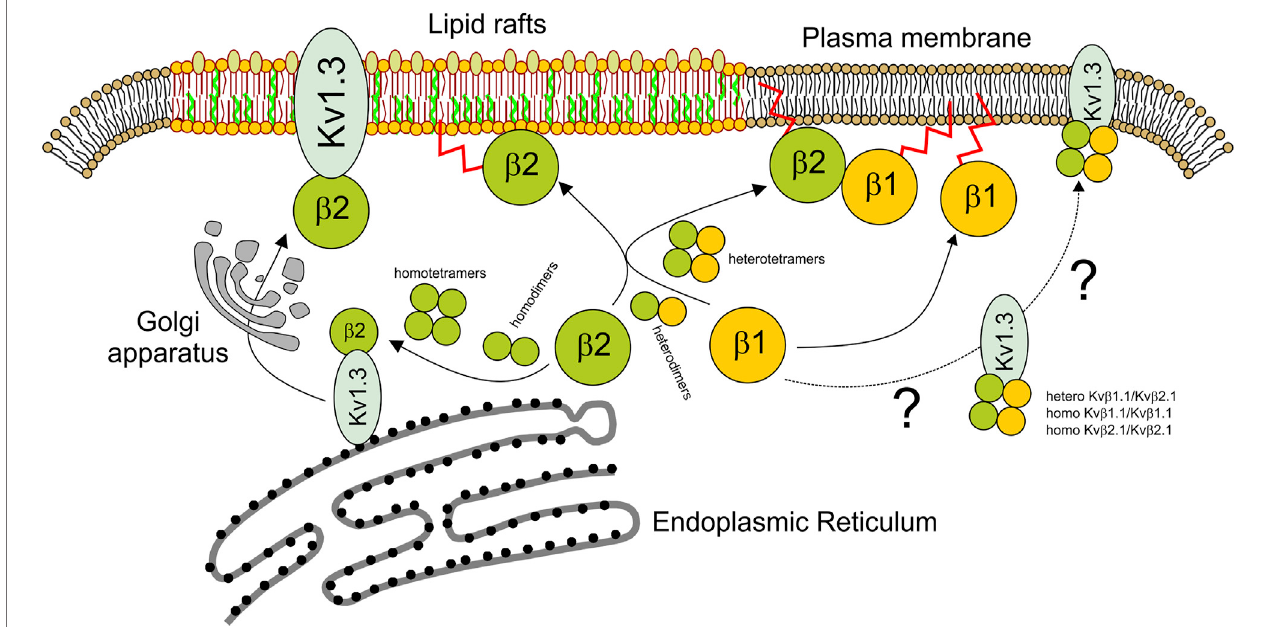
FIGURE8| Schemerepresentingthehomo-andheteromericKv β fate.WhilethetetramericKv1.3channelisassembledearlyattheER,solubleKv β issynthesized inthecytoplasm.Kv β wouldformhomo-andheterodimers.Kv β tetramerswouldbeformed bydimerizationofdimers. Kv β tetramers,especiallyKv β 2,interactearlywith Kv1.3 to target lipid rafts via the Golgi apparatus. The extent to which Kv1.3 associated with Kv β 1.1 or Kv β 1.1/Kv β 2.1 tetramers follows different destinies outside lipid rafts is uncertain. In the absence of a channel, Kv β 2.1 tetramers target lipid rafts in a palmitoylation-dependent manner. However, Kv β 2.1 could also interact with Kv β 1.1, forming heterotetramers. In this context, not only homo-Kv β 1.1 but also Kv β 1.1 – Kv β 2.1 heterotetramers would be displaced from lipid rafts targeting other plasmamembrane surfacelocations.Bythismechanism, Kv β 1.1 fi ne-tunestheKv β 2.1-dependent physiological mechanisms atspeci fi ccellsurfacespots.Blueshape, Kv1.3; green balls, Kv β 2.1; yellow balls, Kv β 1.1. Kv β palmitoylation (red